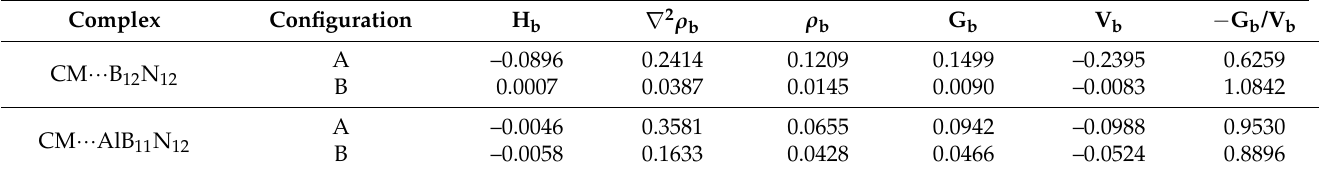
Table 2. Total energy density (H b ), Laplacian ( ∇ 2 ρ b ), electron density ( ρ b ), kinetic electron density (G b ), local potential electron energy density (V b ), and negative ratio of kinetic and potential electron energy density ( − G b /V b ) of the CM ··· B 12 N 12 and ··· AlB 11 N 12 optimized complexes. All parameters are given in